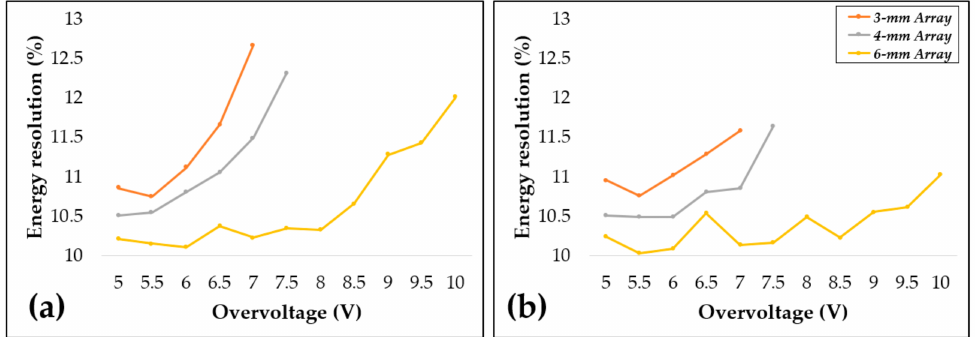
Figure 8. Average energy resolution as a function of overvoltages: ( a ) With and ( b ) without applica- tion of the analog high-pass